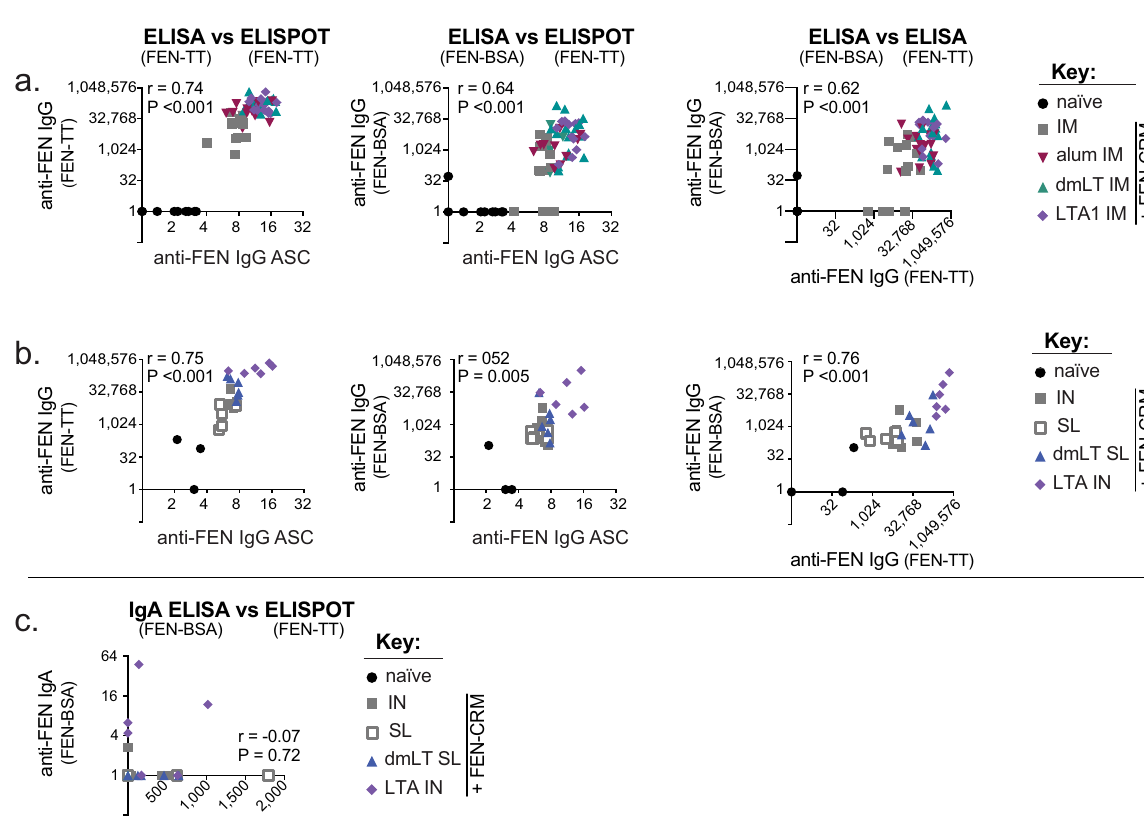
Fig. 5 Signi fi cant correlations between anti-FEN IgG antibody analyses by serum ELISAs and ASC ELISPOT. a Correlations between indicated IgG ELISAs or ELISPOT results with coating antigen indicated in parenthesis using compiled data from FEN-CRM ± adjuvants IM prime/boost or prime/boost/boost experiments. b Correlations between indicated IgG ELISAs or ELISPOT results with coating antigen indicated in parenthesis using compiled data from FEN-CRM ± adjuvants prime IM and mucosal (SL or IN) booster experiments. c Correlations between indicated IgA ELISAs or ELISPOT results with coating antigen indicated in parenthesis using compiled data from FEN-CRM ± adjuvants prime IM and mucosal (SL or IN) booster experiments. ELISPOT data graphed as bone marrow ASC per 1e6 cells (log10). ELISA data graphed as serum IgG EU/ml (log2). Spearman correlations P values and correlation coef fi cient ( r ) indicated on each